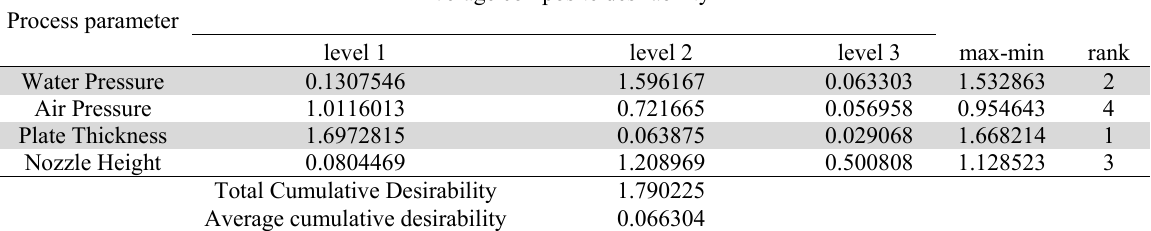
Response table for composite desirability Process parameter